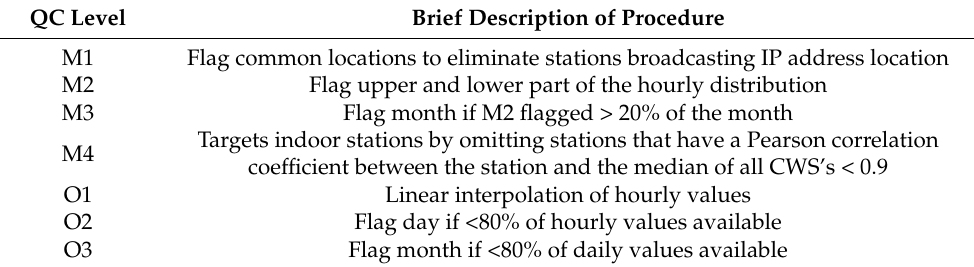
Table 1. Brief description of the levels of the quality check (QC) that was used for Netatmo data in this study. Table adapted from Napoly et al.